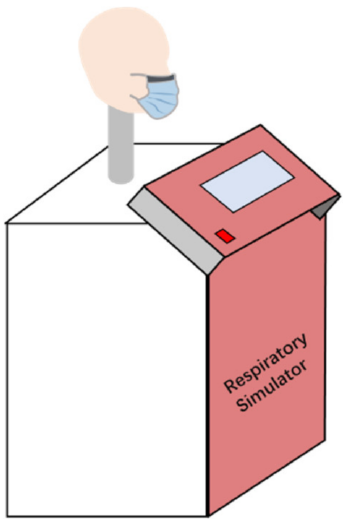
Figure 2. Simulation of wearing masks for different